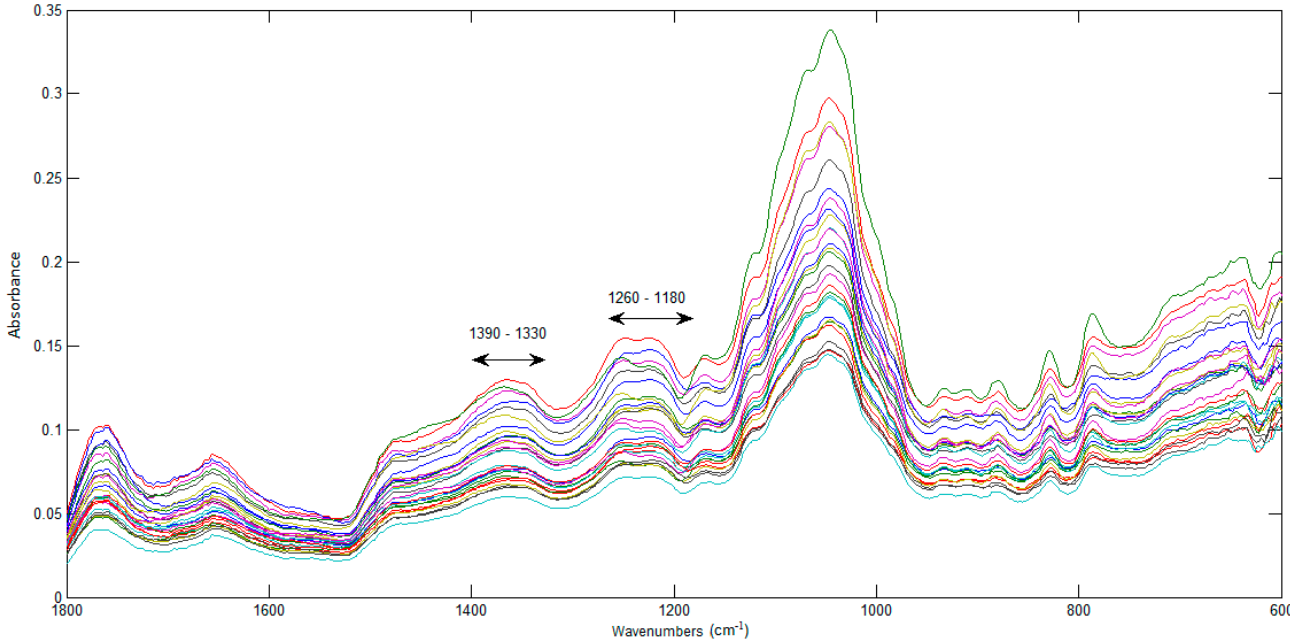
Figure 7. FTIR spectra of the jabuticaba peel flours.